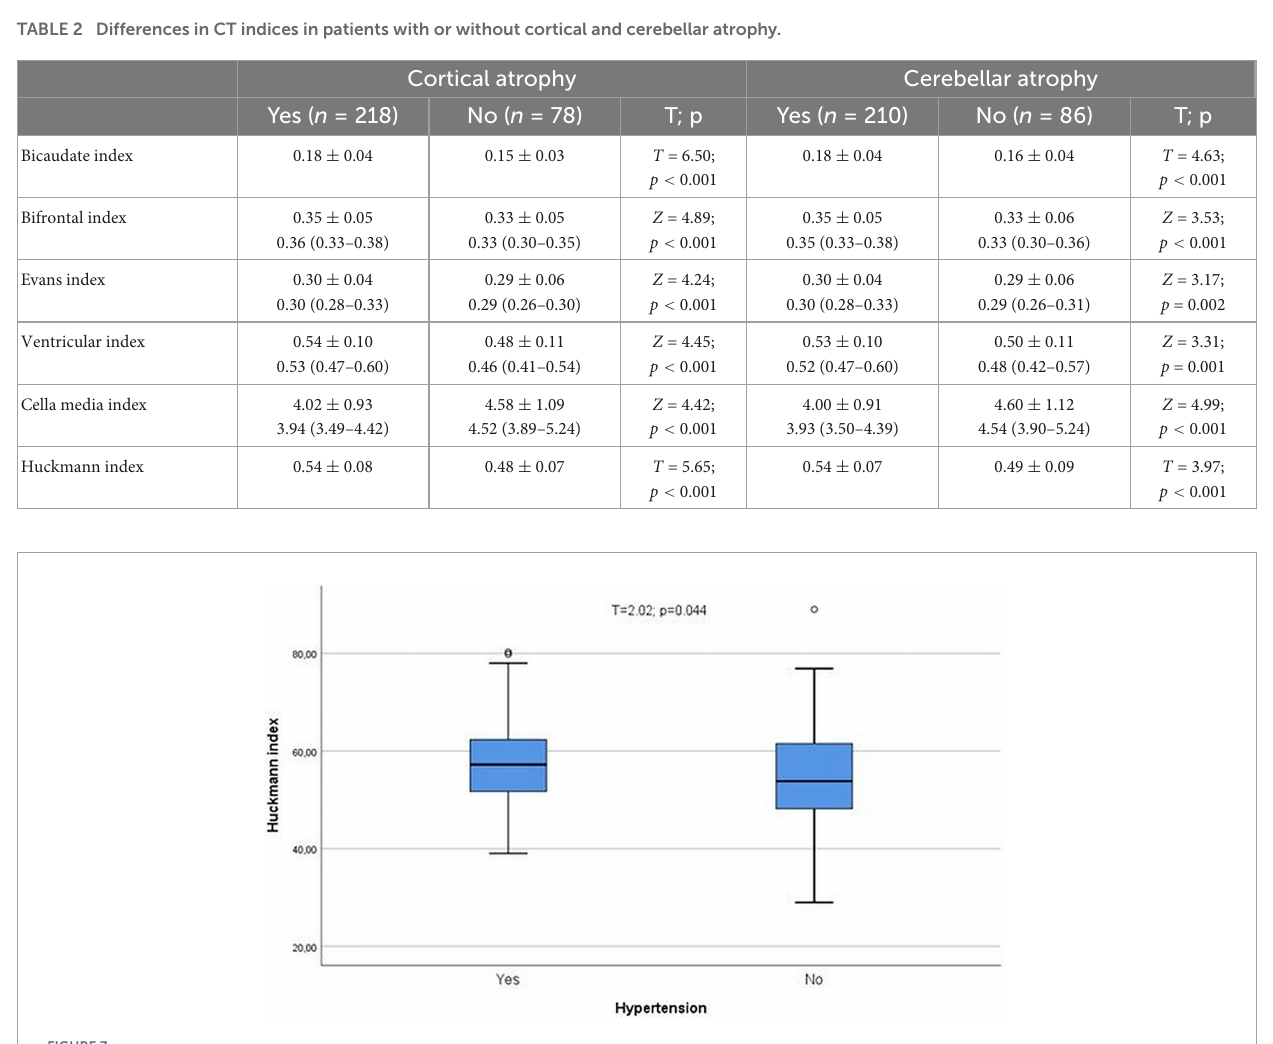
FIGURE7 Patients with hypertension showed a greater atrophy estimated by Huckmann index ( T = 2.02; p = 0.044). ◦ Represent the outliers and *represent the extreme